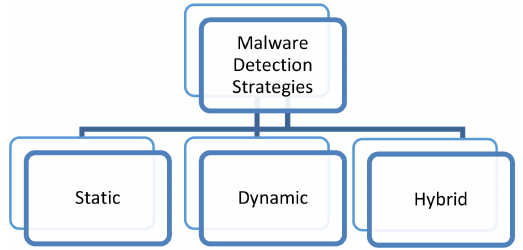
Figure 1. Taxonomy of Malware